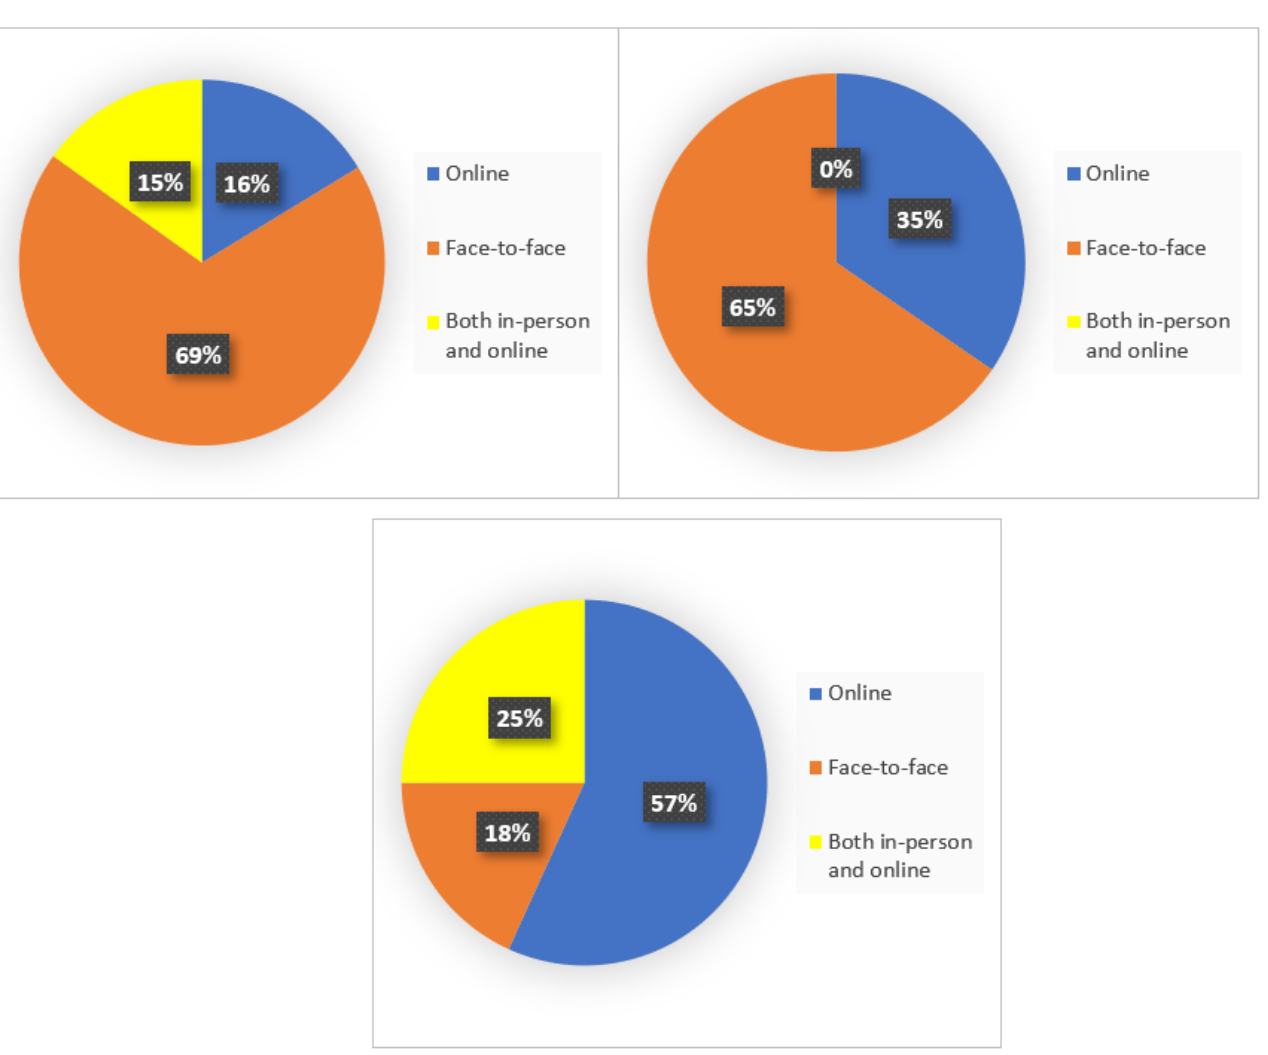
Figure 3. Mode with which psychological support was delivered in Italy, Europe, and extra-Euro- pean